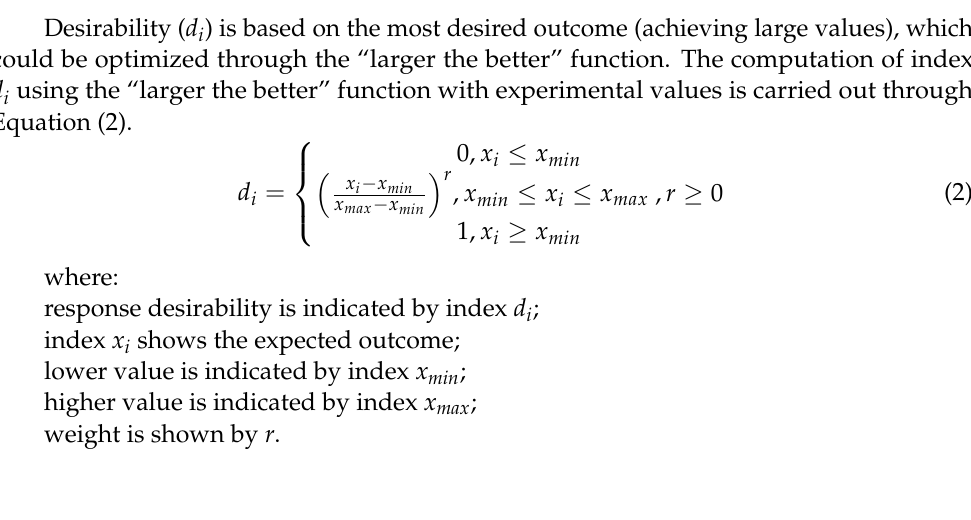
Figure 14. Chemical analysis of ( a ) kerosene-based dielectric at pulse ON:OFF time of 50:50 µSec, and using a graphite electrode and ( b ) S-60-based kerosene dielectric at 25 g/L, pulse ON:OFF time of 50:100 µSec, and using a graphite electrode.